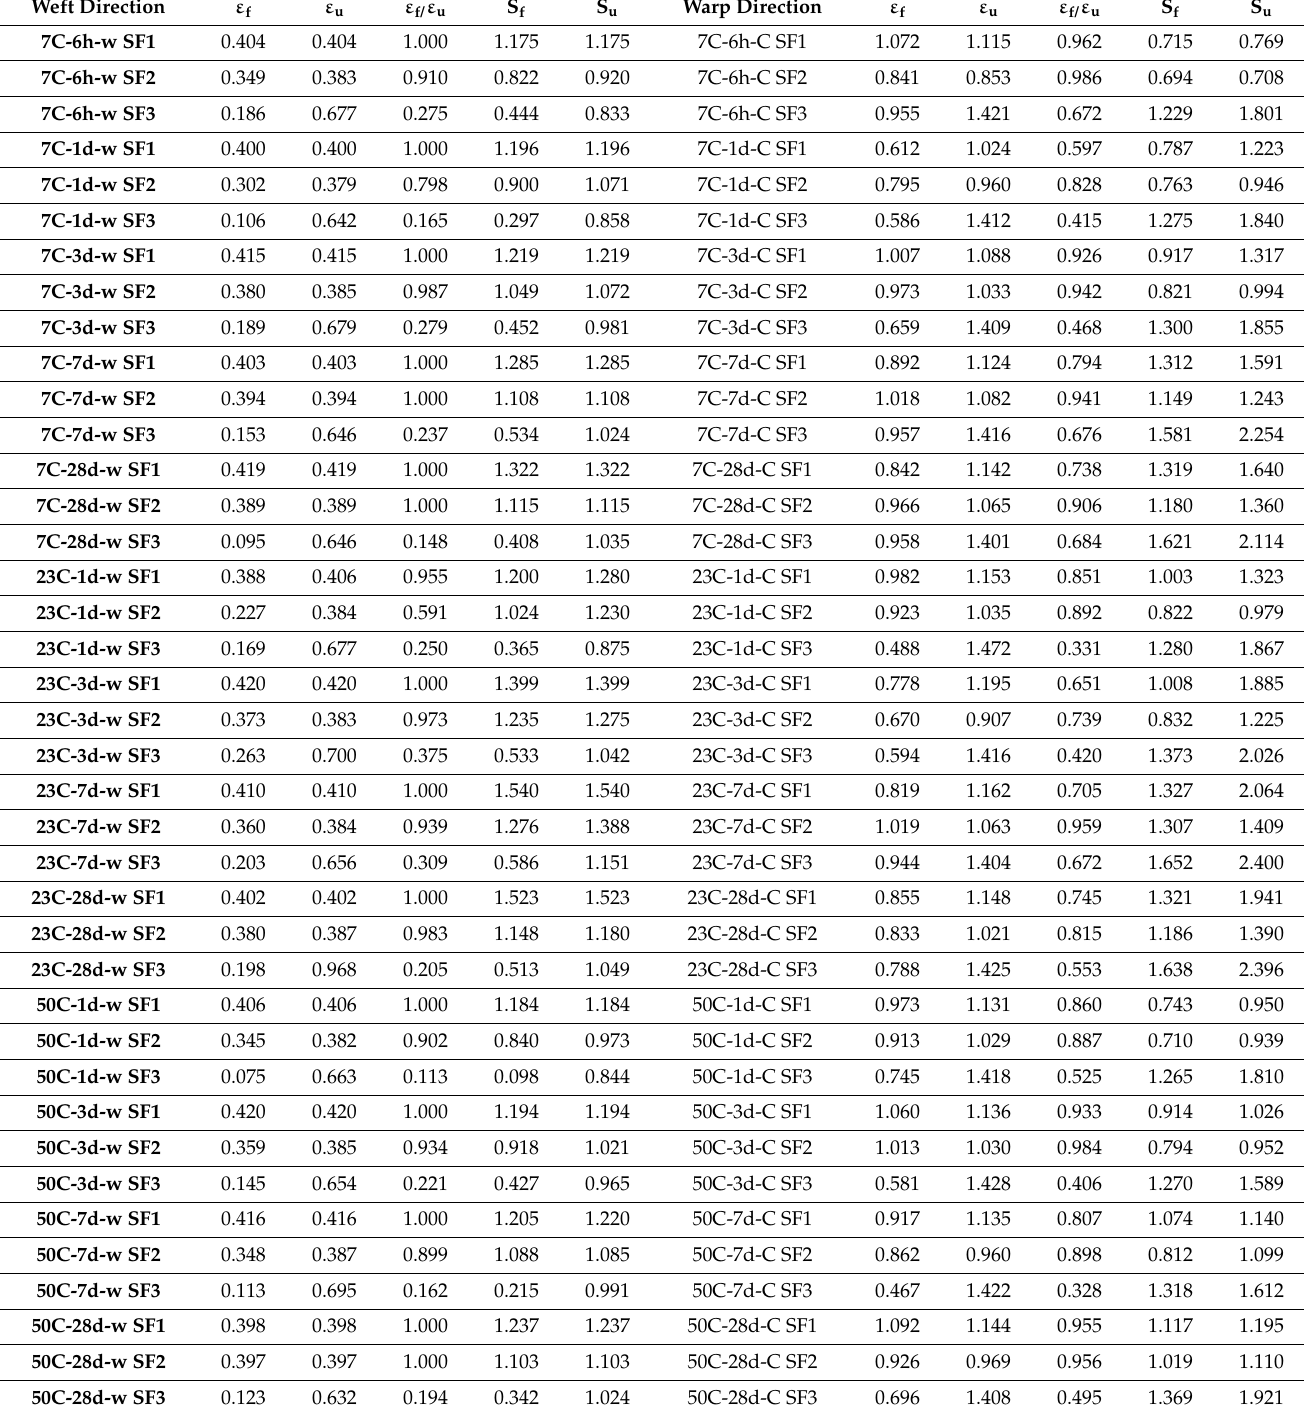
Table 6. Calculation of fracture strain ( ε f ), ultimate strain ( ε u ), cross-sectional strain ( ε f / ε u ), energy absorption until max stress (S f ) and end of the test (S u ) of reinforcement CCs at warp and weft directions. Weft